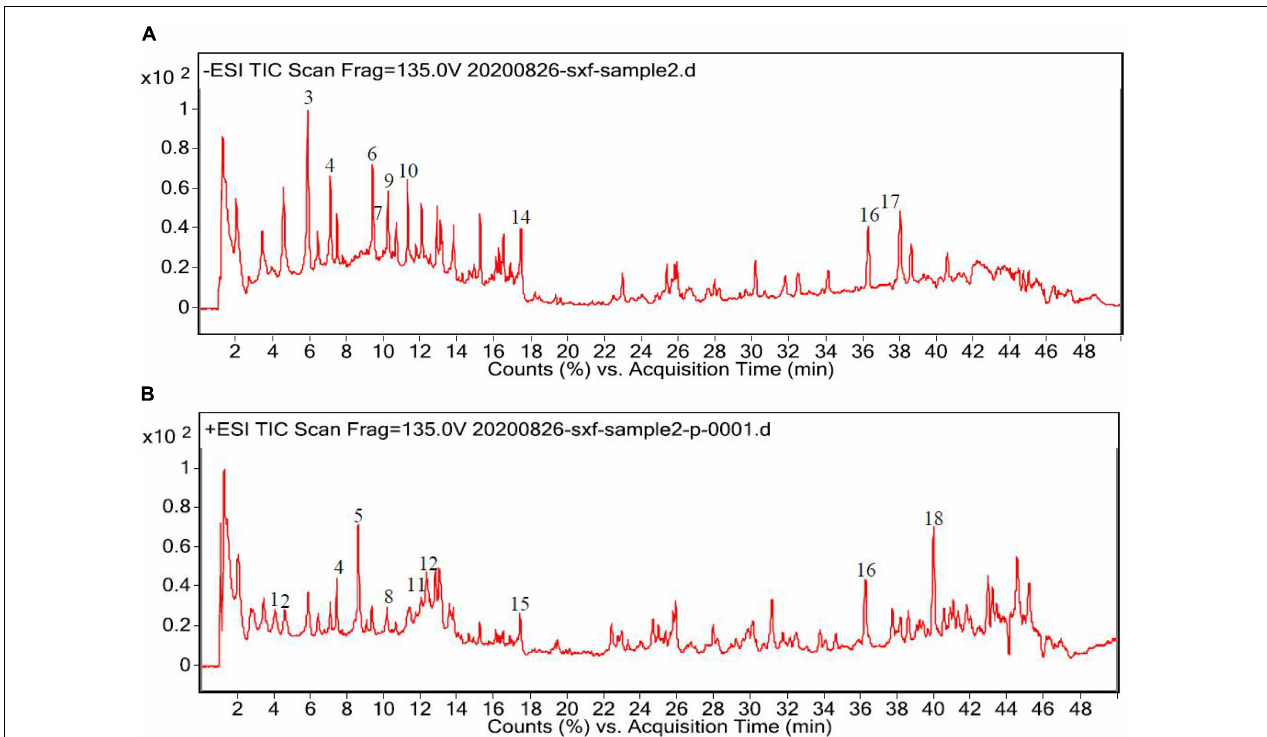
FIGURE 1 | High-performance liquid chromatography (HPLC) chromatograms of the aerial parts of Adonis coerulea (A) for negative mode and (B) for positive mode. 1. L-phenylalanine, 2. caprylic acid, 3. licochalcone A, 4. vitexin, 5. magnoflorine, 6. isoorientin, 7. orientin, 8. 5 (cid:48) -hydroxypuerarin, 9. luteolin 5-glucuronide, 10. norwogonin-7-O-glucuronide, 11. bryoamaride, 12. syringaldehyde, 13. 4-methylumbelliferyl glucuronide, 14. 3-Rha-7-Rha quercetin, 15. strophanthidin, 16. linolenic acid, 17. linoelaidic acid, 18.